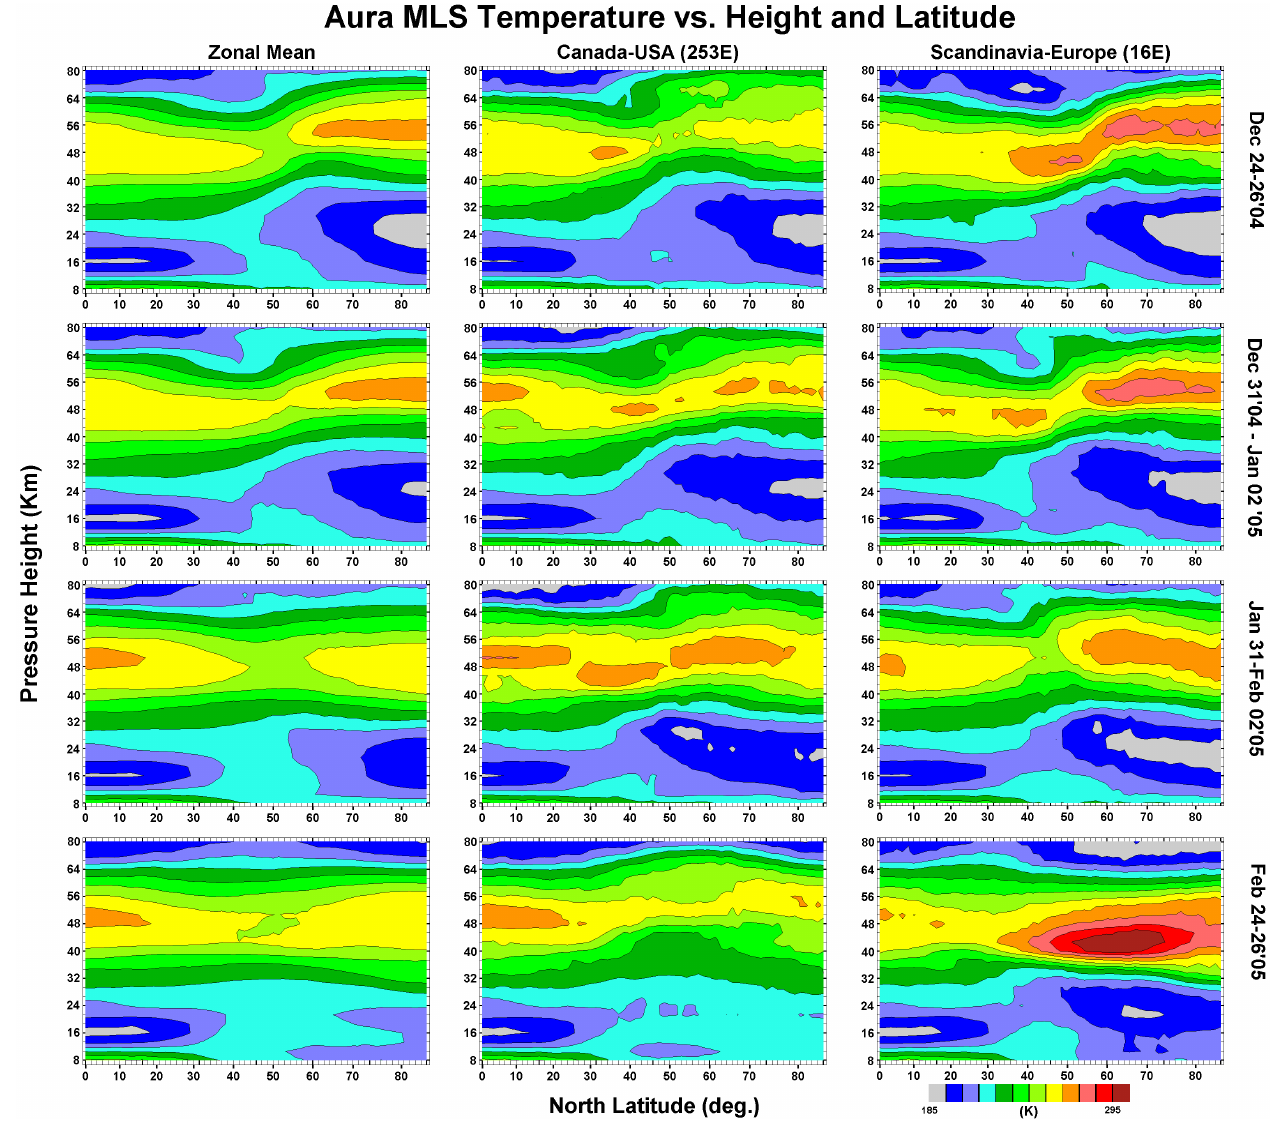
Fig. 1. Aura MLS middle atmosphere temperatures for four time-intervals and at two longitudinal locations plus the zonal mean during winter 2004/2005. The longitudinal sectors are of 25 ◦